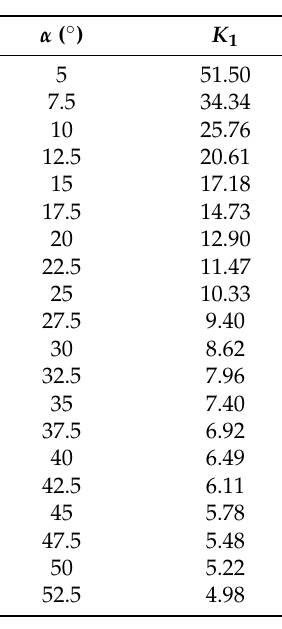
Table 1. Dichotomy calculation result of K 1 .